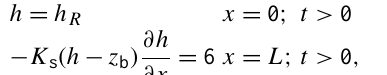
plot showing the seasonal water table response. Flow lines are effectively perpendicular to the head contours